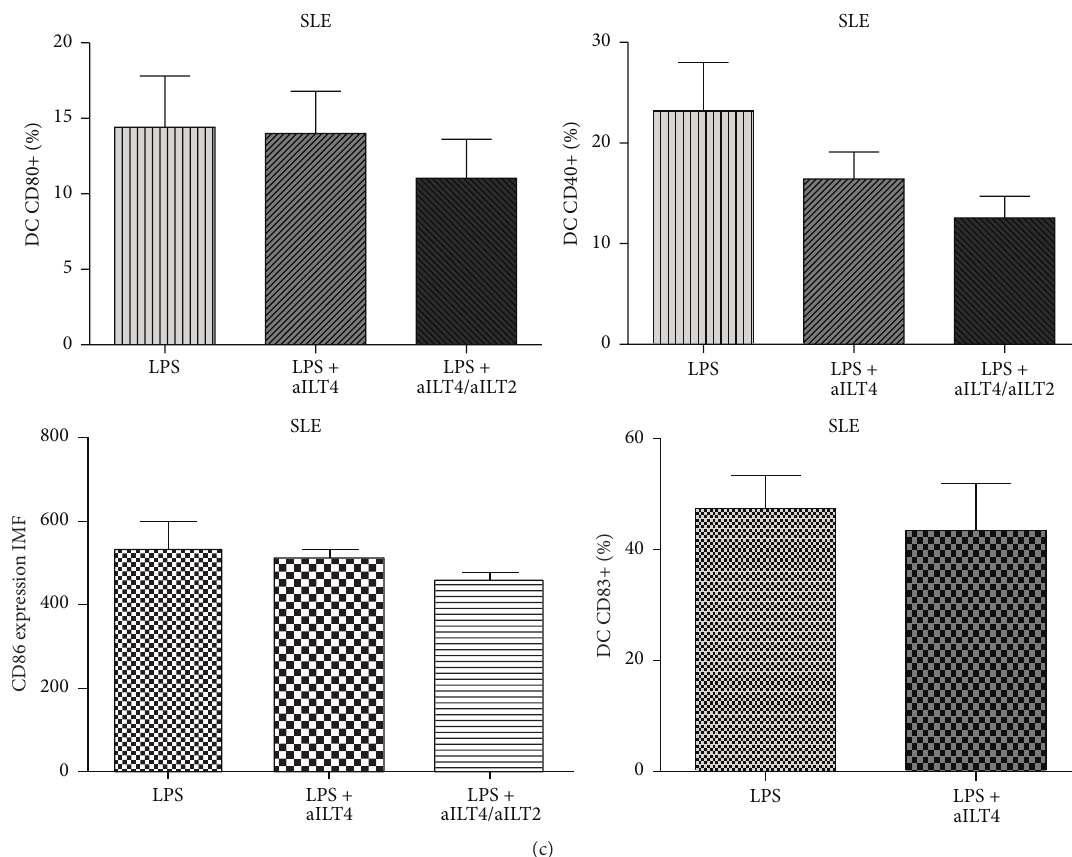
Figure 3: Effect of ILT4 on the expression of costimulatory molecules by mature moDC from healthy controls and SLE patients. (a) Representative dot plots for the expression of CD80 and CD40 in healthy controls (left panel) and SLE patients (right panel). Numbers represent the percentage of CD80 and CD40 positive cells. (b) Analysis of the expression of maturation markers in mature DC from healthy controls and SLE patients, in response to continuous ligation of ILT4 or ILT4/ILT2. Results are represented as the median and the interquartile